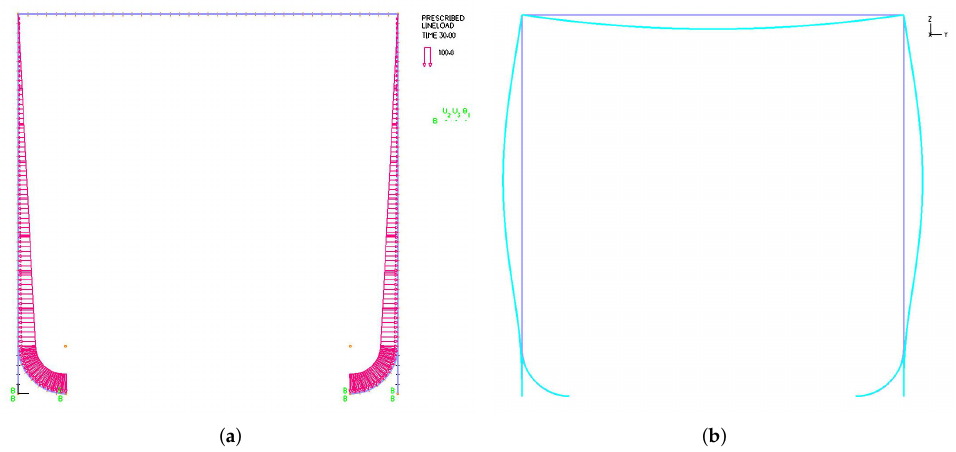
Figure 11. ADINA simulation of the full-fledged beam-column model with curve corners as well as straight side walls welded to the tank bottom. ( a ) 2D model with stiffened curved corner, ( b ) Deformation. All stiffeners in holding tanks are made of 3 (cid:48)(cid:48) × 6 (cid:48)(cid:48) × 1